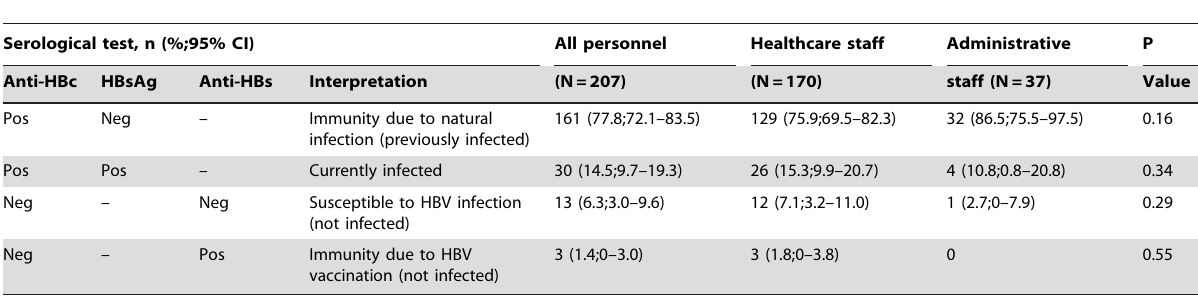
Table 3. HBV serology in personnel (n =207) at Niamey’s National Hospital, Niger, 2009.